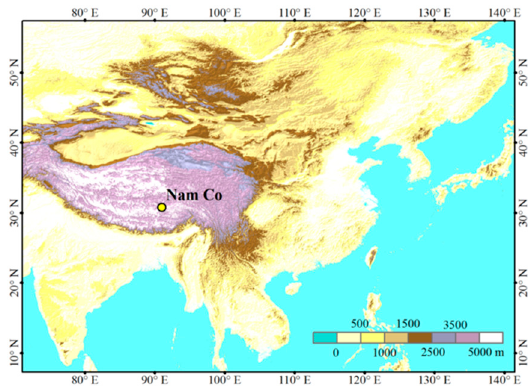
Figure 1. Measurement site and the surrounding areas.